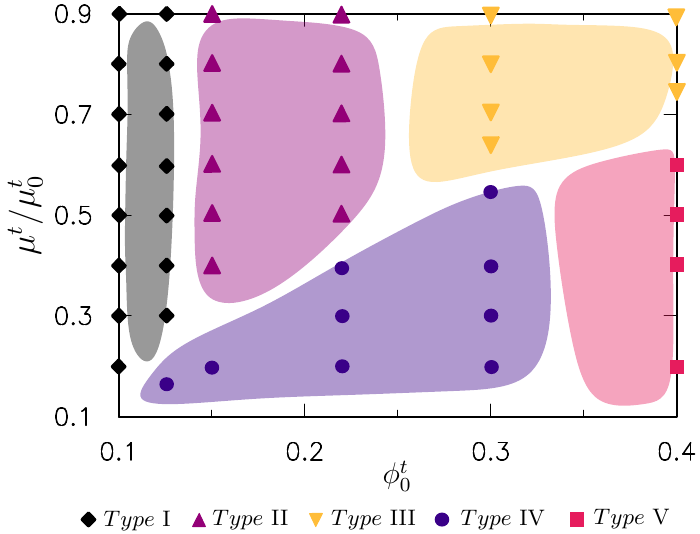
Figure 9. Predicted phase diagram by finite element (FE) simulations for the occurrence of typical surface morphologies (types I, II, III, IV, and V) shown in Figures 7 and 8. The phase diagram was constructed as a function of the initial absorption of water µ t / µ t chain φ t of the bilayer hydrogel under both the pre-absorption of water in the upper layer and 0 mechanical compression. The initial volume fraction of polymer chain in the bottom layer was fixed as = φ b 0